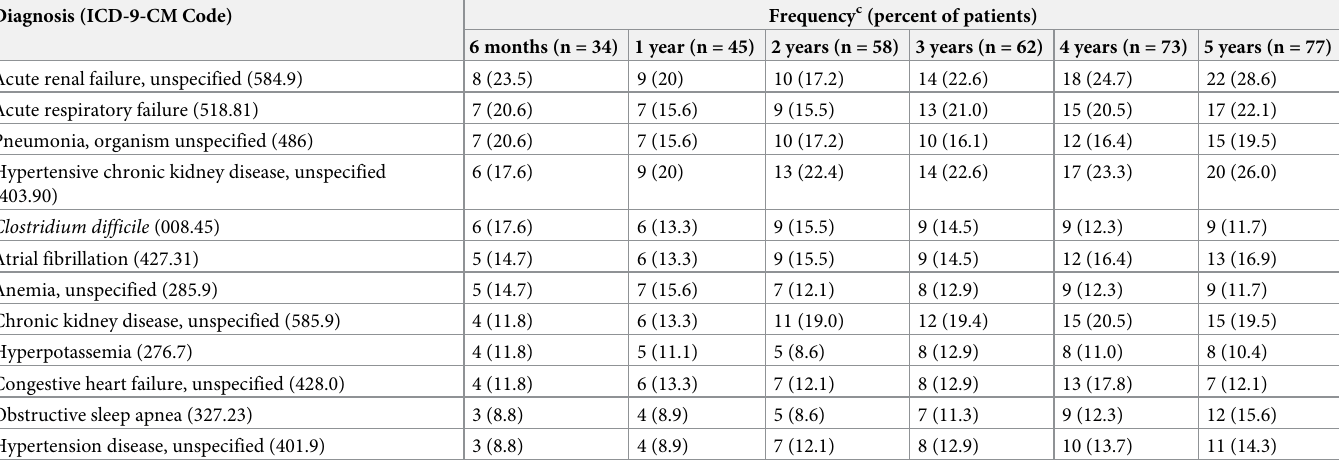
Table 4. Most frequent a administrative discharge diagnosis codes after diagnosis of Legionnaires’ disease, at 6 months after LD and cumulative annually for five Federal Fiscal Years b (n = 77)–frequent diagnoses that were present in all six time increments. Diagnosis (ICD-9-CM Code) Frequency c (percent of